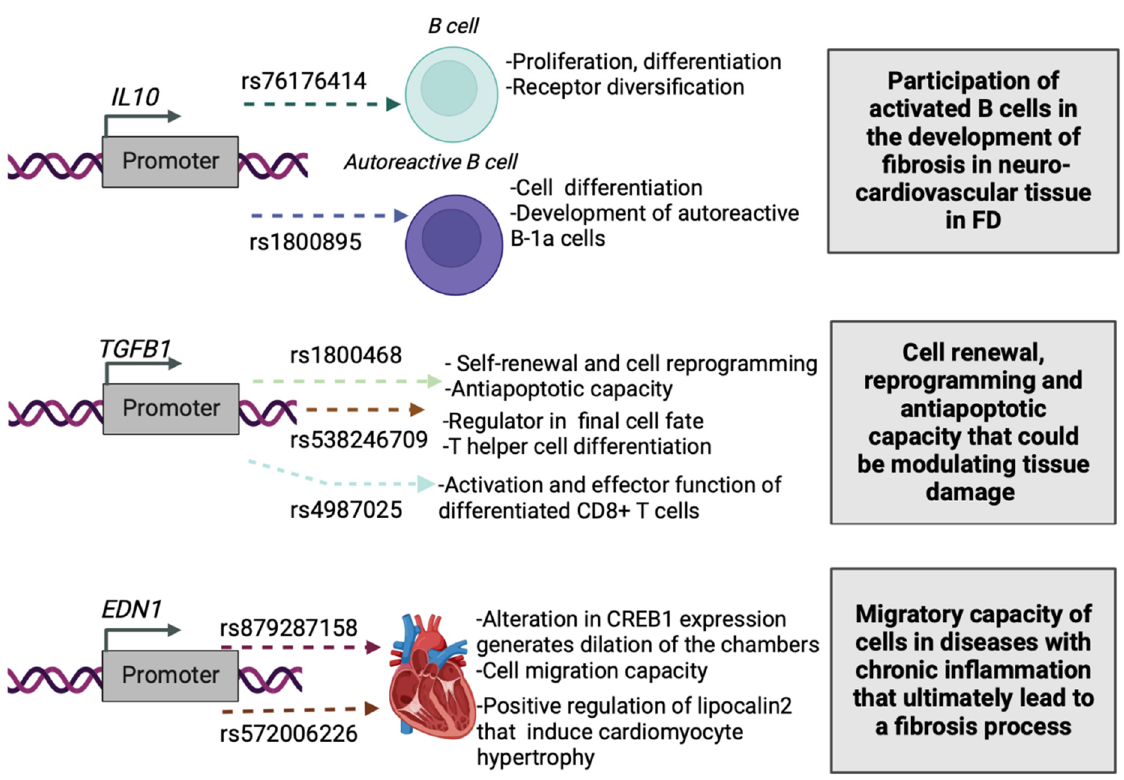
1 . Chromatin-accesible cell line: Hcm (Human Cardiac Myocytes), Hcf (primary Human Cardiac Fibroblasts), Hac (Astrocytes-cerebellar), Huvec (Umbilical vein endothelial cells), T H 1. Binding score for the Major Allele (RBS M ), RBS for the Minor Allele (RBSm), affinity impact (%), homotypic redundance (HR), homotypic redundance weight factor (HWF) and functional impact factor (FIF), Ruiz Ram í rez et al. [30]. 2 . Negative values in FIF indicate a prediction of decreased affinity between TF-DNA of minor allele compared with major allele. Positive values in FIF indicate a prediction of increased affinity between TF-DNA of minor allele compared with major allele. Positive values of FIF >10 suggest the creation of a new TFBS.